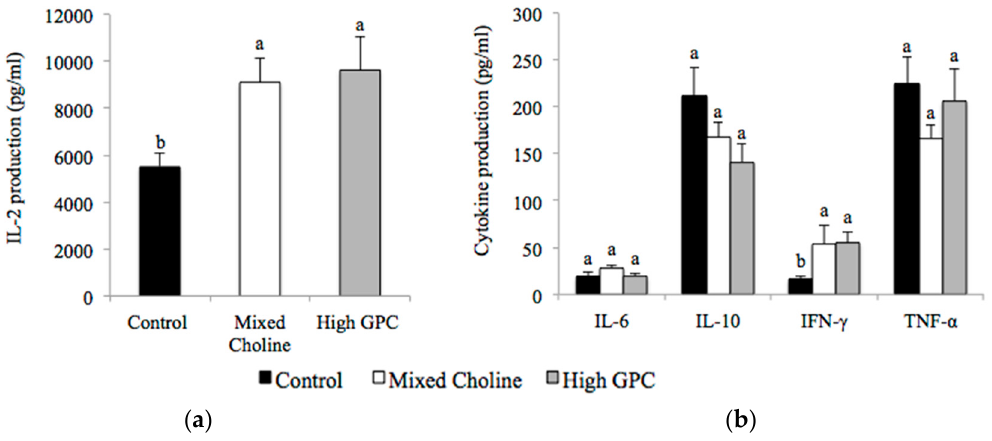
Figure 2. IL-2 production ( a ) and cytokine production; ( b ) by mesenteric lymphocytes after ex vivo